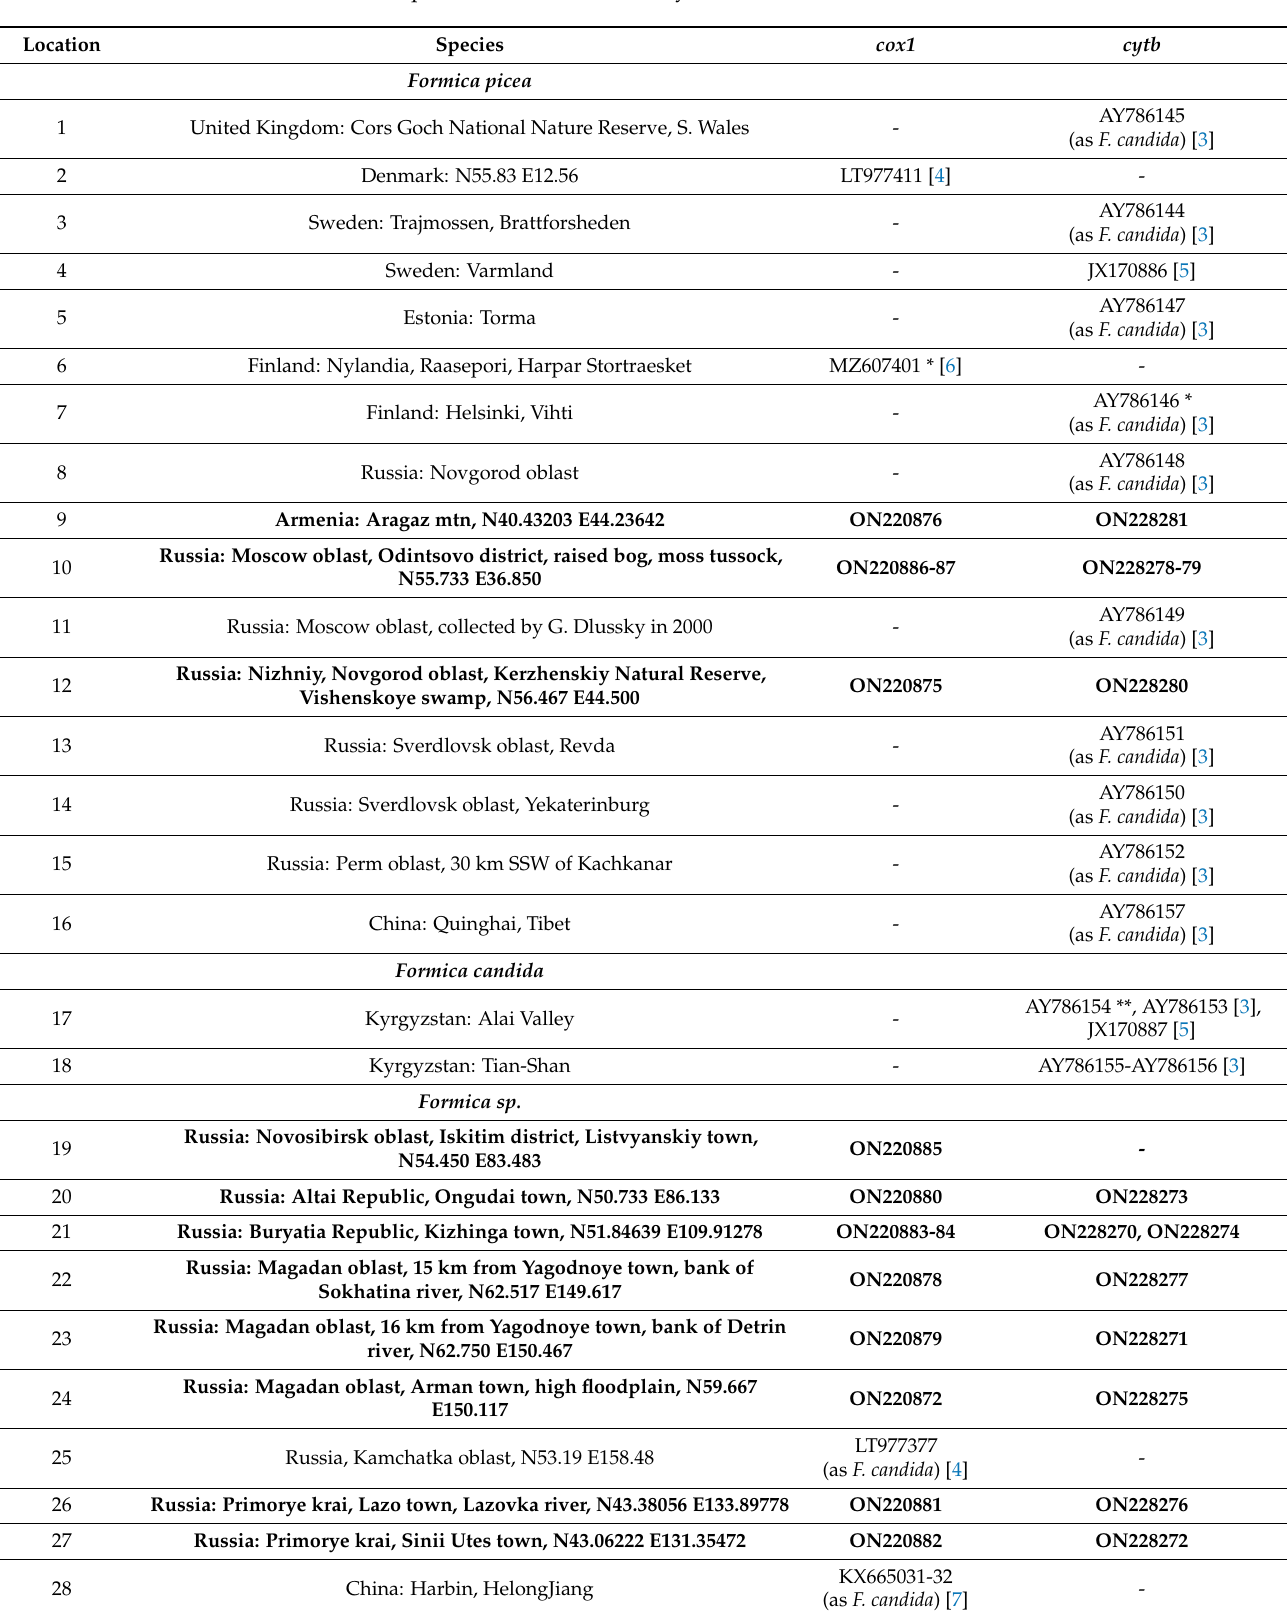
Table 1. Specimens used in this